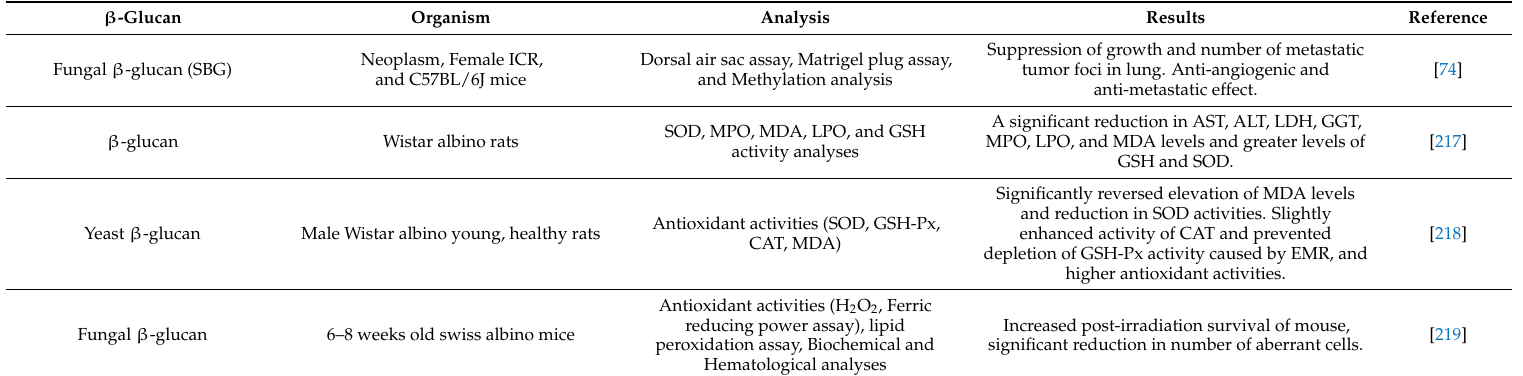
Table 16. Antigenotoxicity/antimutagenicity/antioxidative effects of β -glucans—animal